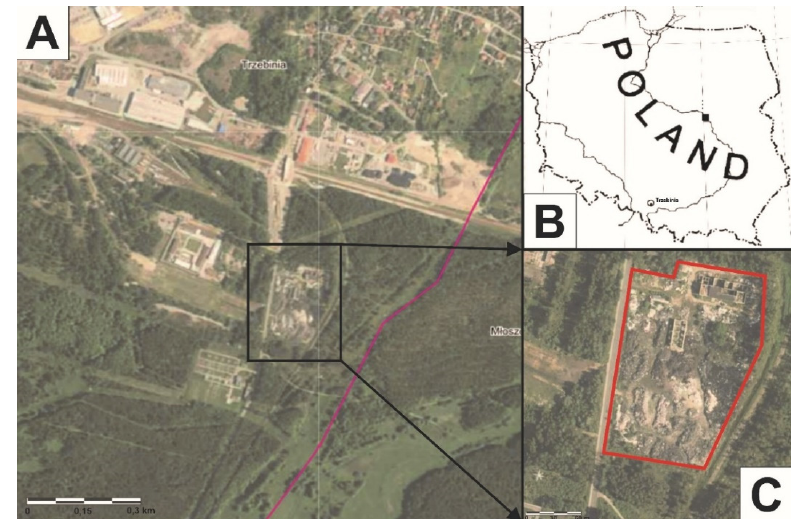
Figure 1. ( A – C ) Wild landfill fire location in Trzebinia on Słowackiego Street.